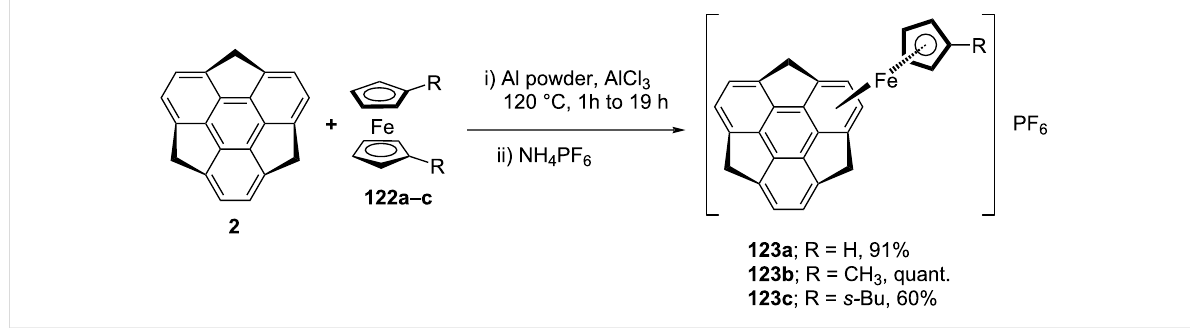
Scheme 30: Synthesis of the iron-complex of sumanene.